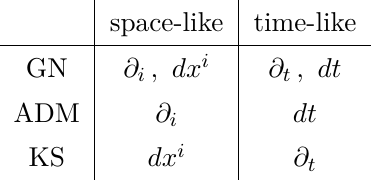
Table 1 . We’ll refer to a coordinate system ( t, x i ) as a space-time split or d + 1 decomposition if it falls into either the ADM or KS class (the GN class is the intersection of both). They are defined by the properties of the coordinate bases of tangent and co-tangent spaces, as listed in this